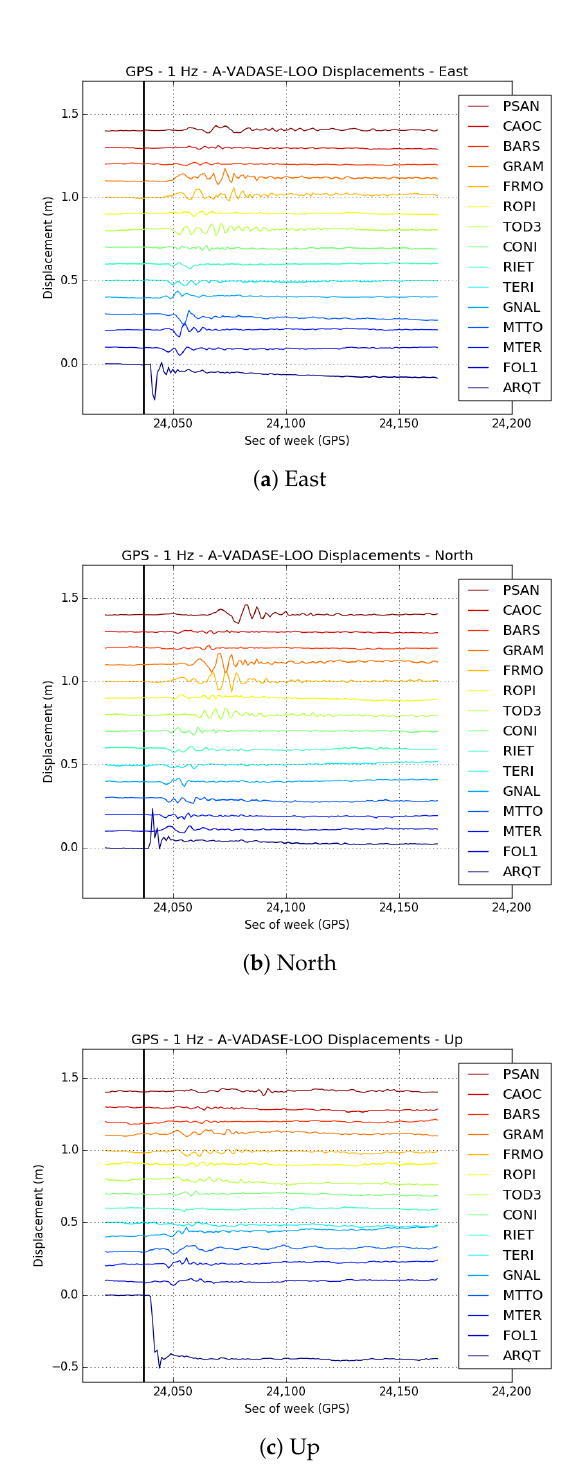
Figure 5. Estimated displacements after detrending by A-VADASE-LOO for the 150-s interval across the 30 October 2016 main shock (GPS